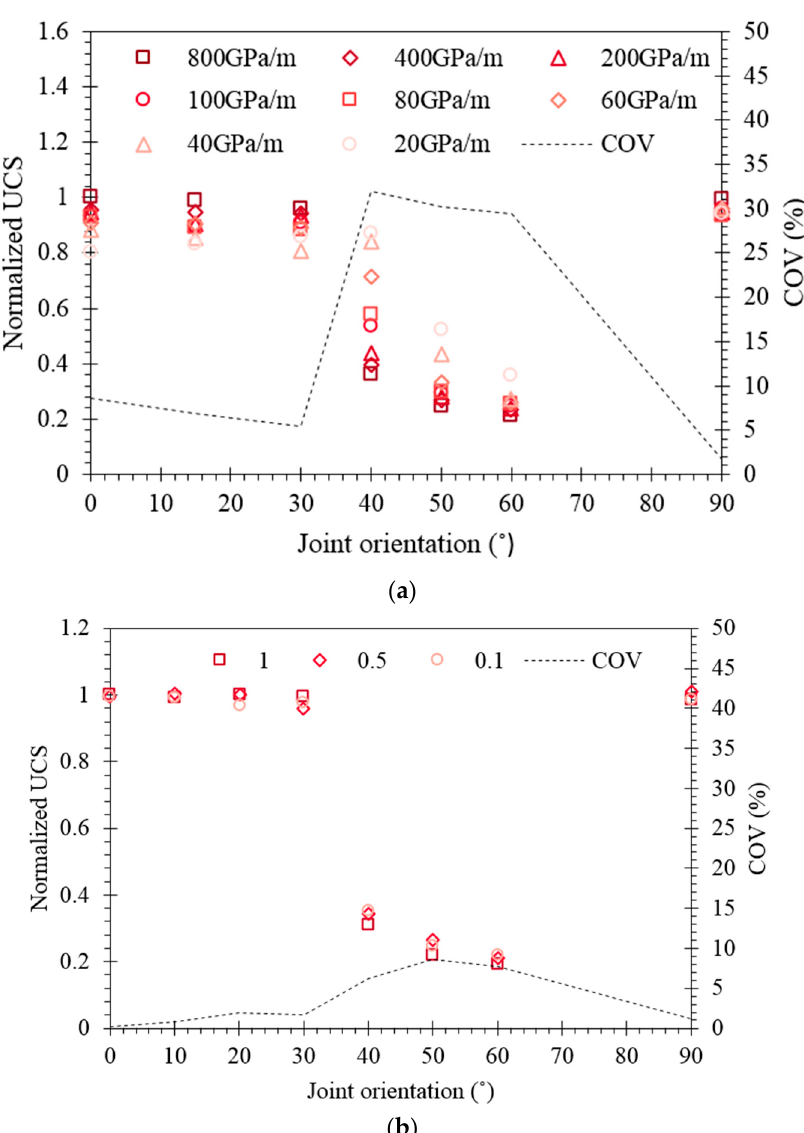
Figure 5. Effect of normal stiffness ( a ) and stiffness ratio ( b ) of the SJM on the failure strength of the jointed rock mass.